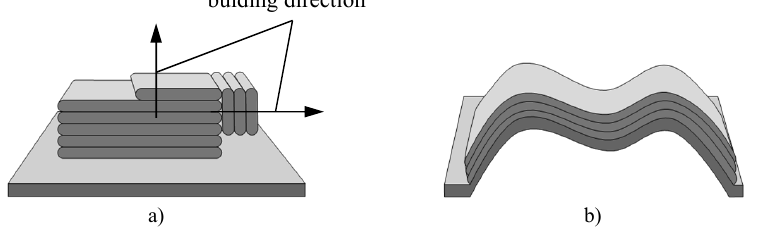
Figure 1. Illustration of multidirectionality with variable building direction of: ( a ) subvolumes; and ( b ) curved